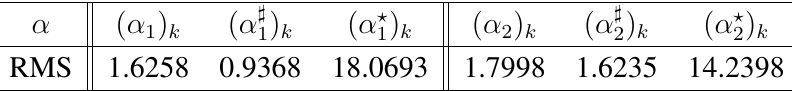
Table 1. RMS of the fault estimation errors.